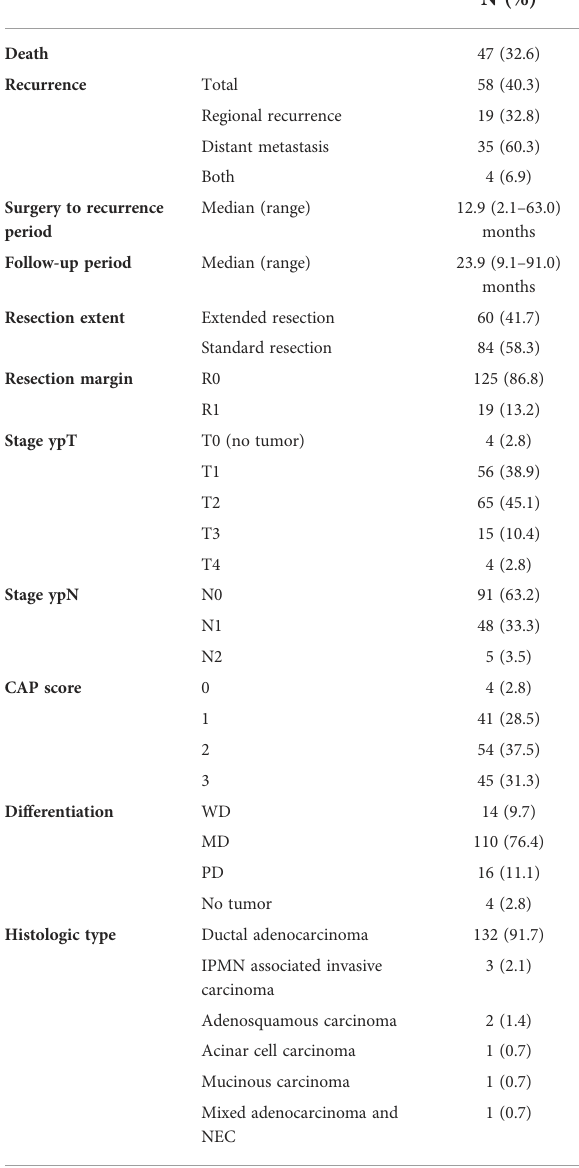
TABLE 2 Results of surgical pathology and clinical